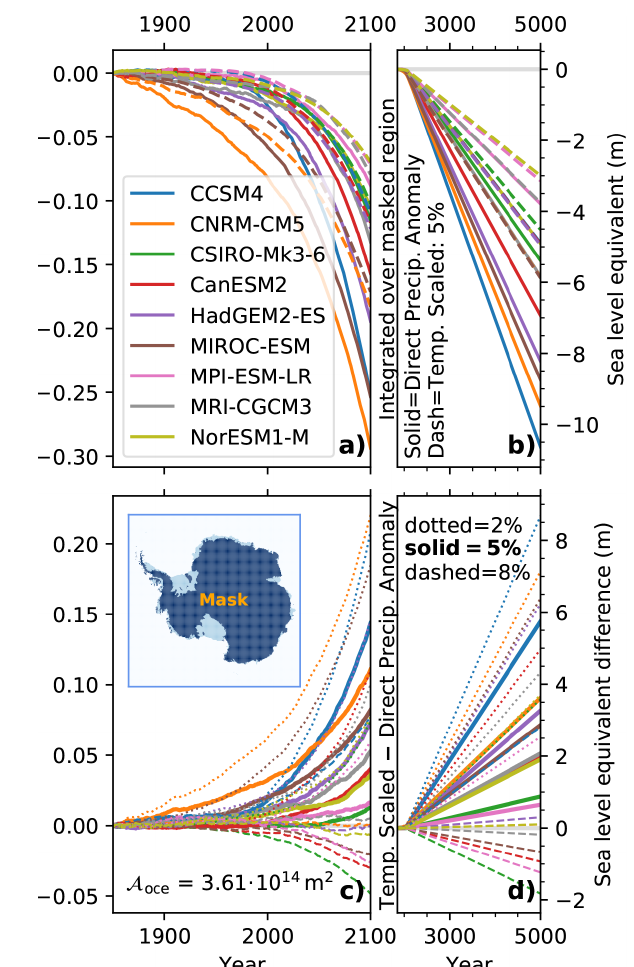
Figure 6. Panels (a) and (b) show the integrated potential sea level equivalent of the precipitation falling on grounded ice in Antarc- tica (see the dark-blue mask in the lower left, where the light-blue parts highlight ice shelves); the grounded and floating ice areas are derived from Fretwell et al. (2013) for the anomaly forcing (solid lines) and temperature-scaled precipitation (dashed lines) consider- ing a scaling of 5%K − 1 . The difference in the potential sea level impact between the anomalies and the temperature-scaled precipi- tation is depicted in panels (c) and (d) . Here, the solid lines consider scaling of 5%K − 1 , and the dotted and dashed lines consider a scal- ing of 2%K − 1 and 8%K − 1 , respectively. Panels (a) and (c) are restricted to the period from 1850 to 2100, whereas panels (b) and (d) cover the full period from 1850 to 5000. Every single colored line (see the legend in a ) represents one CMIP5 model (Table 1). The corresponding curves for the RCP4.5 scenario as well as for a different mask that covers the entire continent are available in Fig.